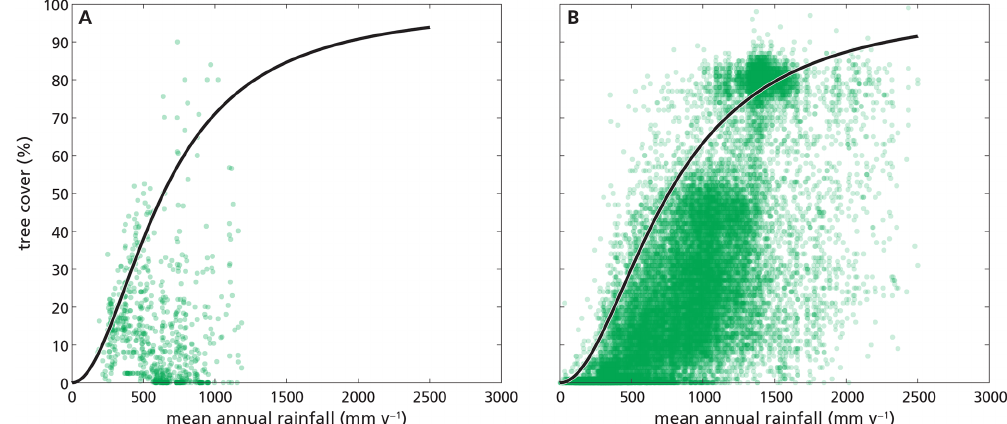
Figure 1. Tree cover as a function of mean annual rainfall (mmyr − 1 ). (a) Savanna field data, reprinted from Sankaran et al. (2005); (b) tree cover obtained from MODIS woody cover product (as in e.g., Hirota et al., 2011), where anthropogenic land use is masked as described in the text. For clarity of representation, we selected only 0.05% of the data. For both databases, we selected only the data points between 35 ◦ S and 15 ◦ N in Africa. The dots are data; the continuous lines are the 90th quantile nonlinear regression (99th quantile not shown; see values of b coefficients in Table S1 in the Supplement). Notice that the field data (a) correspond only to savanna sites, and thus encompass a smaller rainfall range than the satellite data (b)